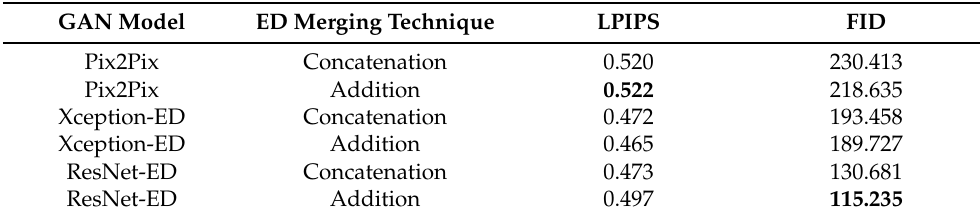
Figure 5. Sample results were obtained by Pix2Pix, Xception-ED, and ResNet-ED with concatenation and addition as feature merging of the encoder and decoder features while training with 100 semantic labels on the ADE20k indoor dataset. Table 2. Comparison between the proposed GAN models trained on NYU depth V2 with 41 semantic labels in terms of LPIPS and FID metrics. Note that the generator and discriminator parameter counts for each model are the same as those values reported in Table 1.